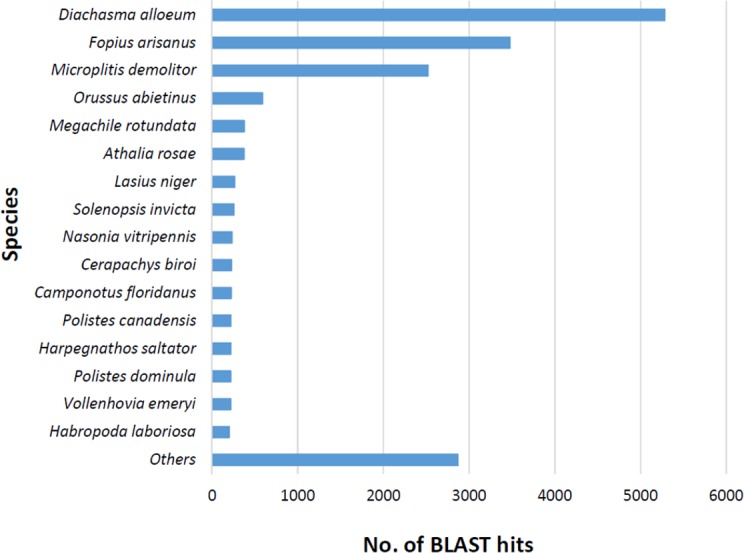
Species distribution of unigene sequences of the aphid parasitoid wasp Aphidius ervi transcripts to other insect species using homologous BLASTx hits and NR-NCBI database.